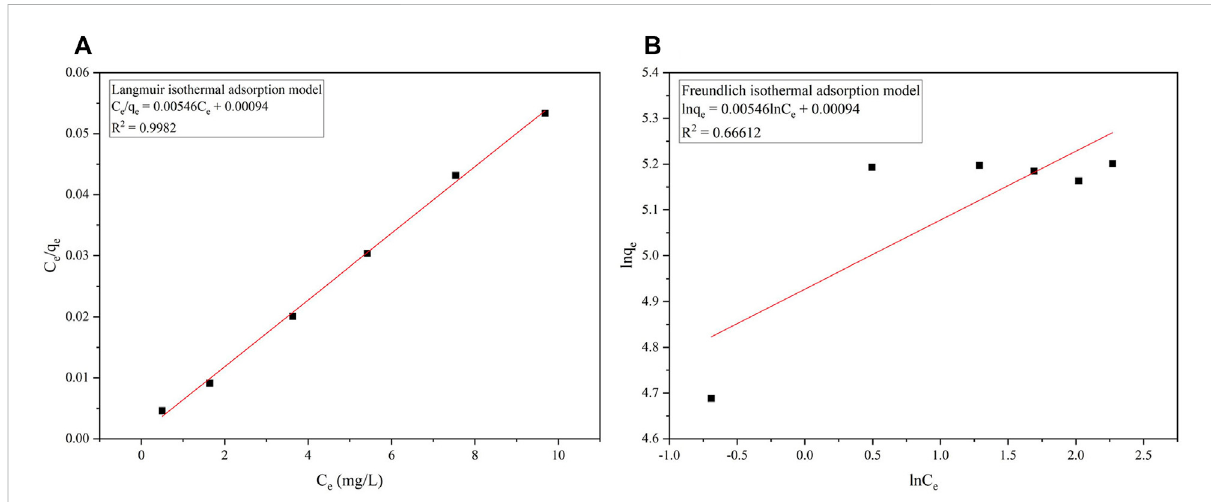
FIGURE 4 Fitting of the isothermal adsorption models. (A) the Langmuir isothermal adsorption model; (B) the Freundlich isothermal adsorption